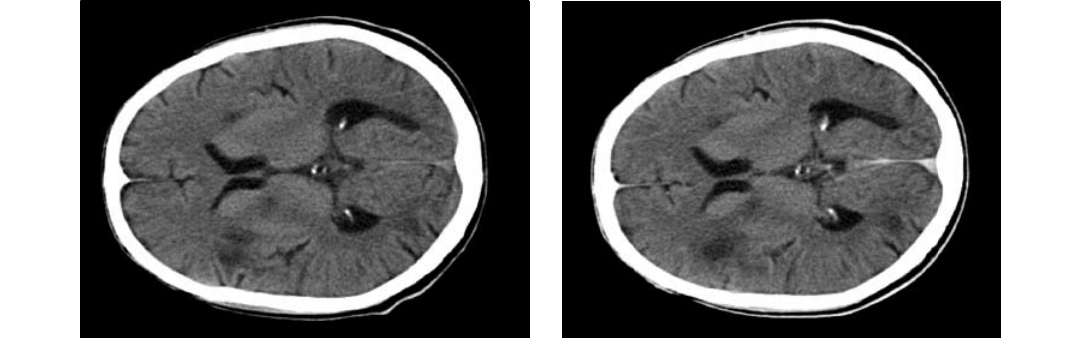
Fig. 1b. No enhancement was demonstrated on post-contrast imaging.